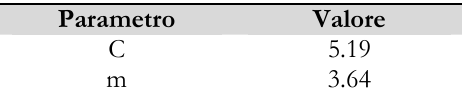
Tabella 2: Coefficienti della legge di Paris.